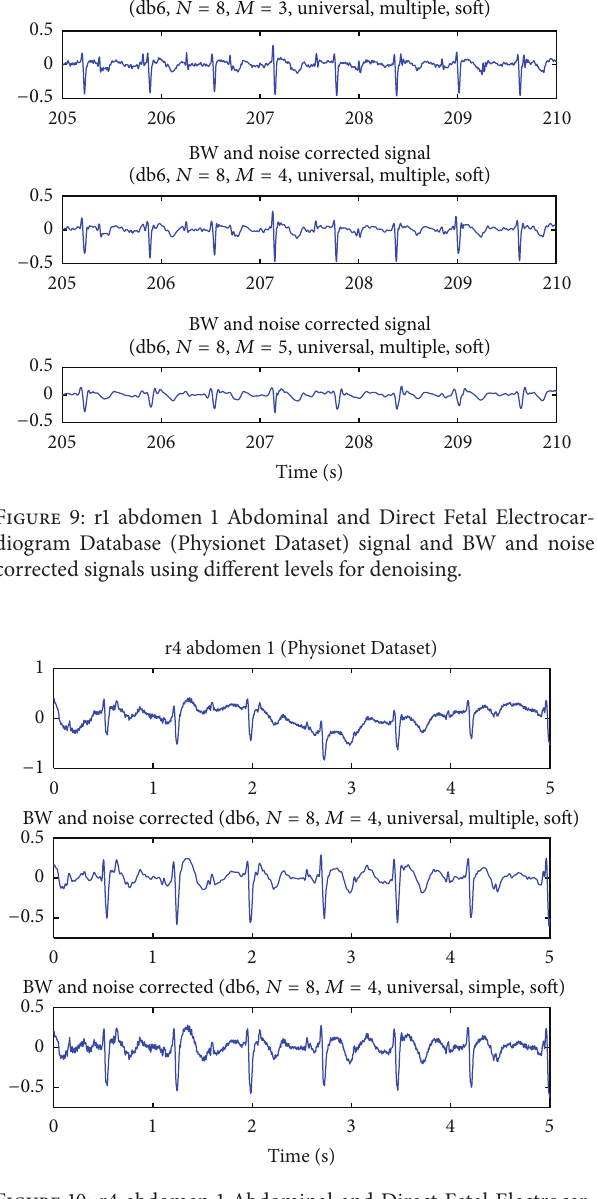
Figure 10: r4 abdomen 1 Abdominal and Direct Fetal Electrocar- diogram Database (Physionet Dataset) signal and BW and noise corrected signals using multiple and simple rescaling.